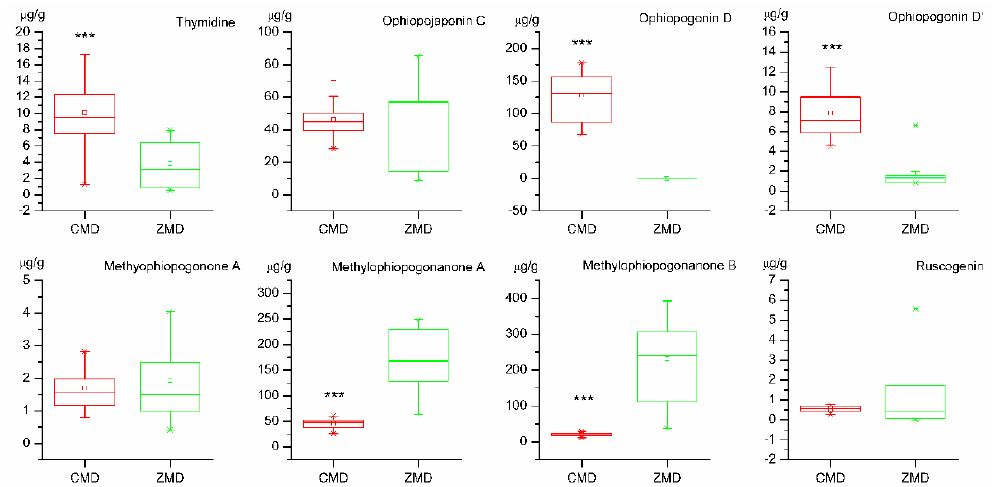
Figure 5. The box plot of 32 compounds contents in Chuan maidong (CMD) and Zhe maidong (ZMD) (*** p < 0.001).